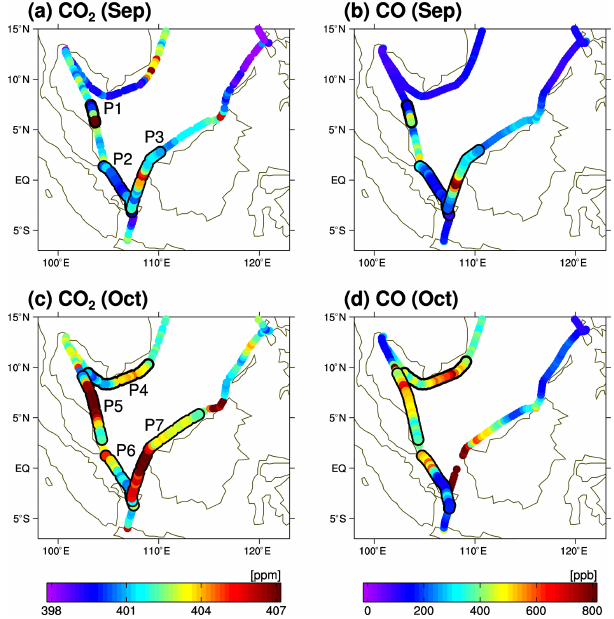
Figure 5. Mole fractions of CO 2 (a, c) and CO (b, d) along the cruise tracks of NIES VOS for September (a, b) and October (c, d) 2015. Data enclosed by black lines with P# represent designated fire-induced high mole fraction events (see also Fig. 6).